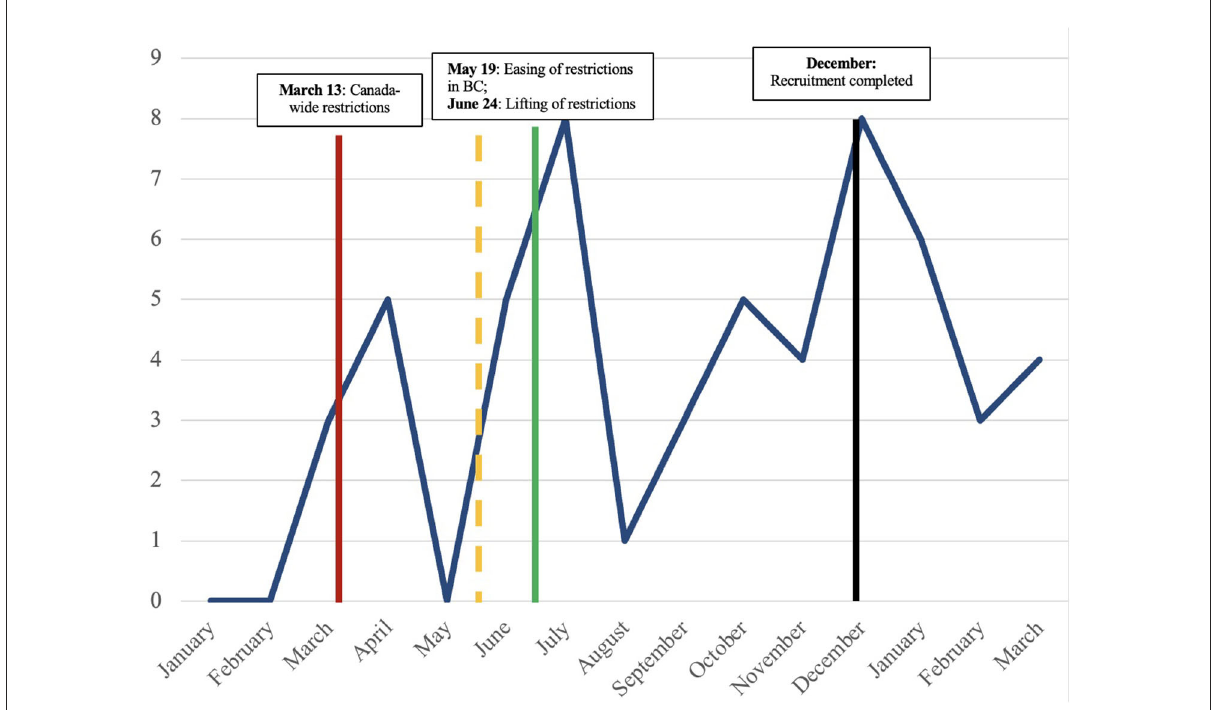
FIGURE3 Number of participants employed from January 2020 to March 2021.